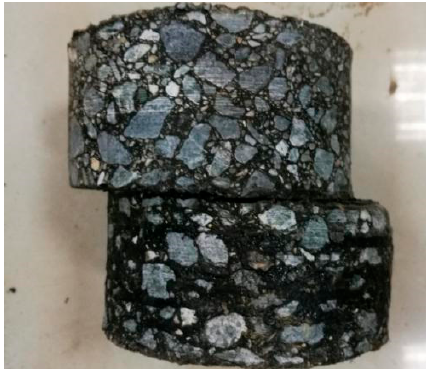
Figure 4. Fog seal specimen.